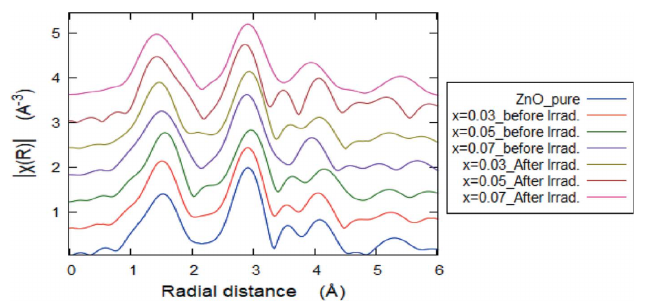
Figure 3 FTs corresponding to k 2 -weighted EXAFS oscillations of Mn-doped ZnO samples at the Zn K -edge with y -offset for clarification.